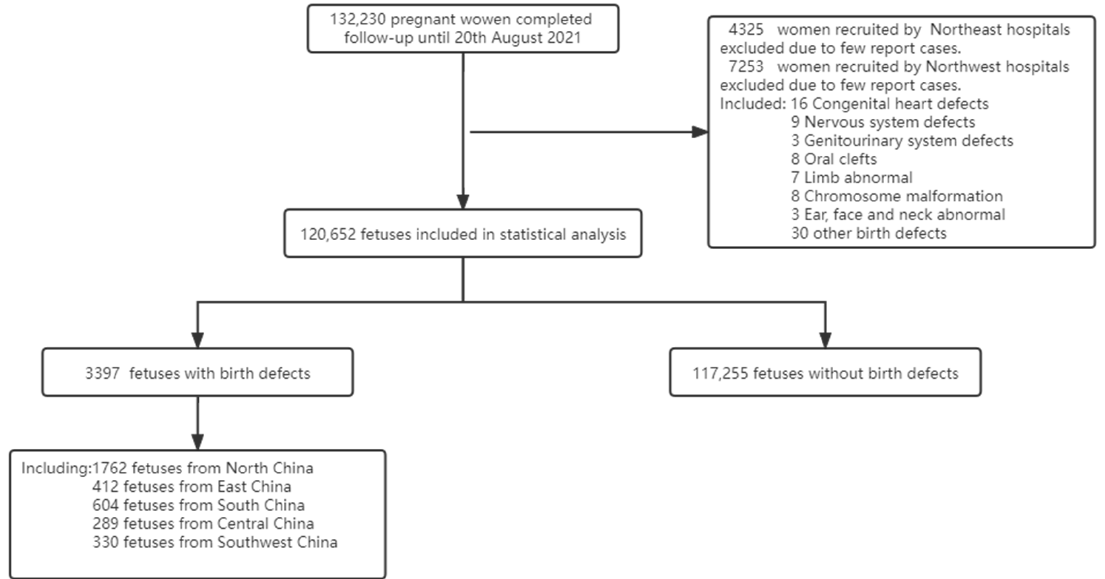
Figure 1. Flow chart of participants.